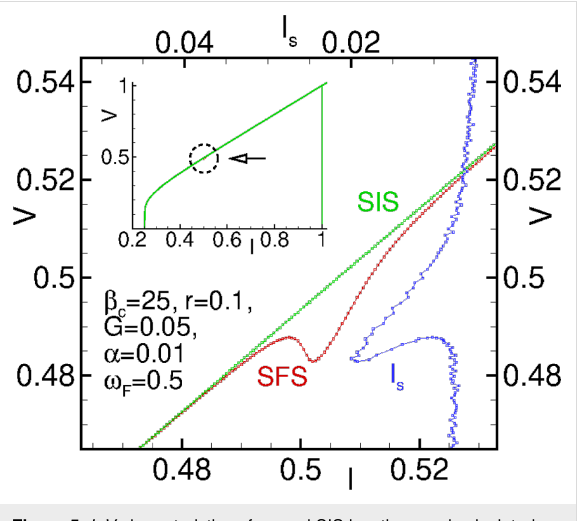
Figure 5: I – V characteristics of φ 0 and SIS junctions and calculated average superconducting current through the φ 0